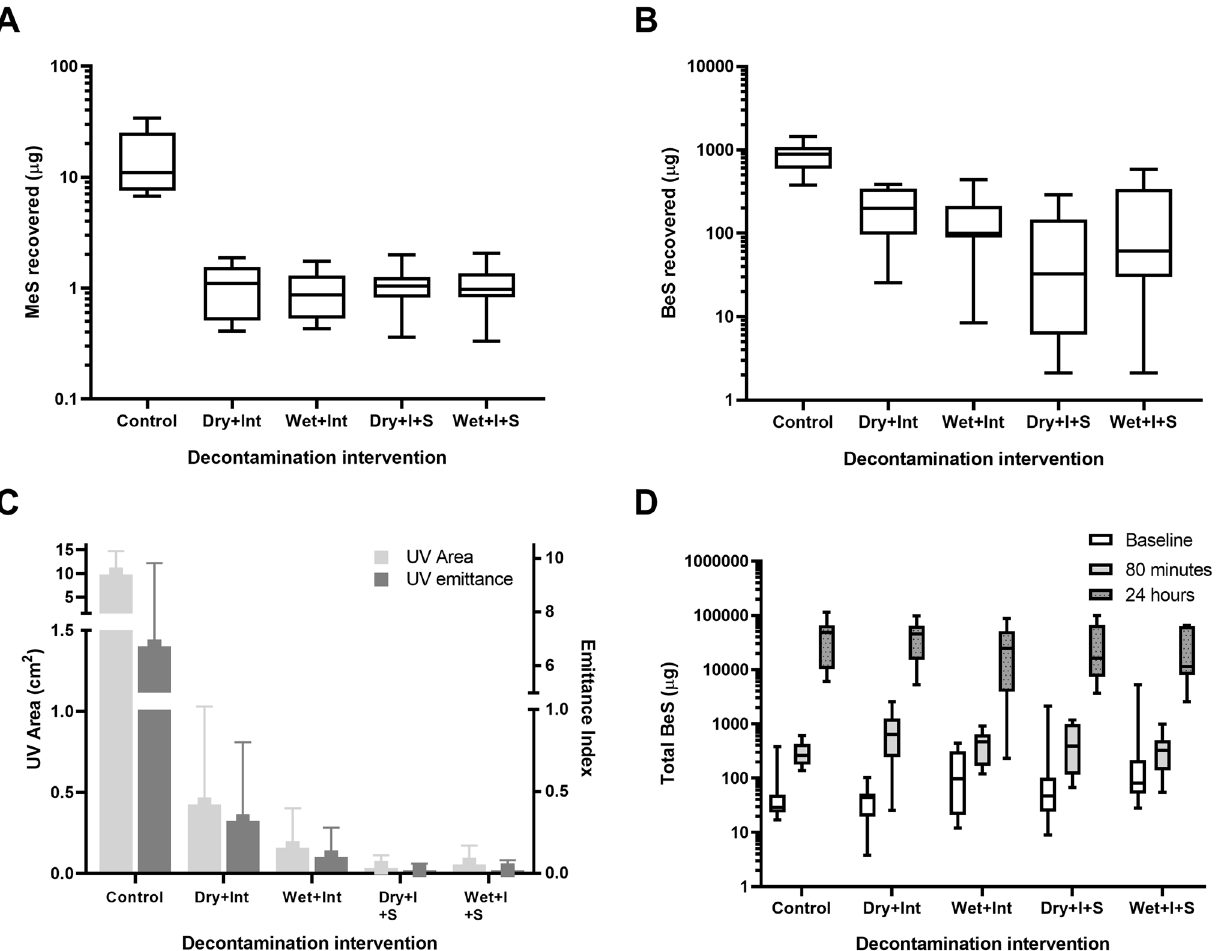
Figure 2. ( A ) MeS recovered from skin for each decontamination condition, ( B ) BeS recovered for each decontamination condition, ( C ) Total simulant area (spread) and emittance (simulant amount) detected by UV image analysis, ( D ) Total BeS excreted in urine for baseline, 80 min and 24 h samples. Box and whisker plots show median and inter–quartile range, together with the maximum and minimum